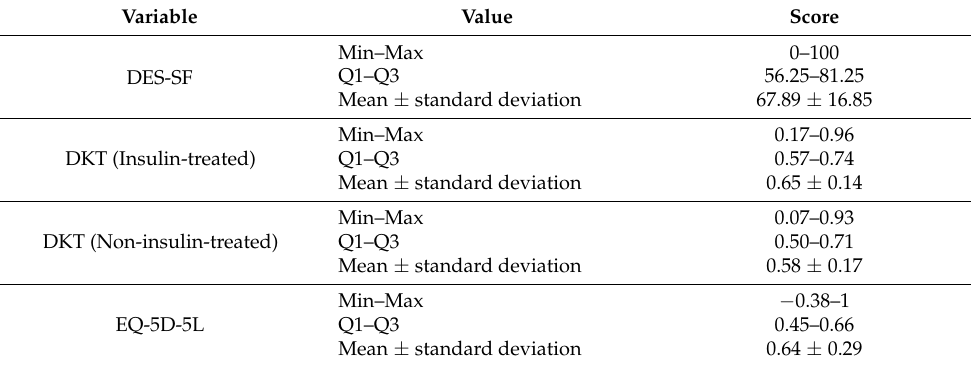
Table 2. Descriptive statistics for the DES-SF, DKT, and